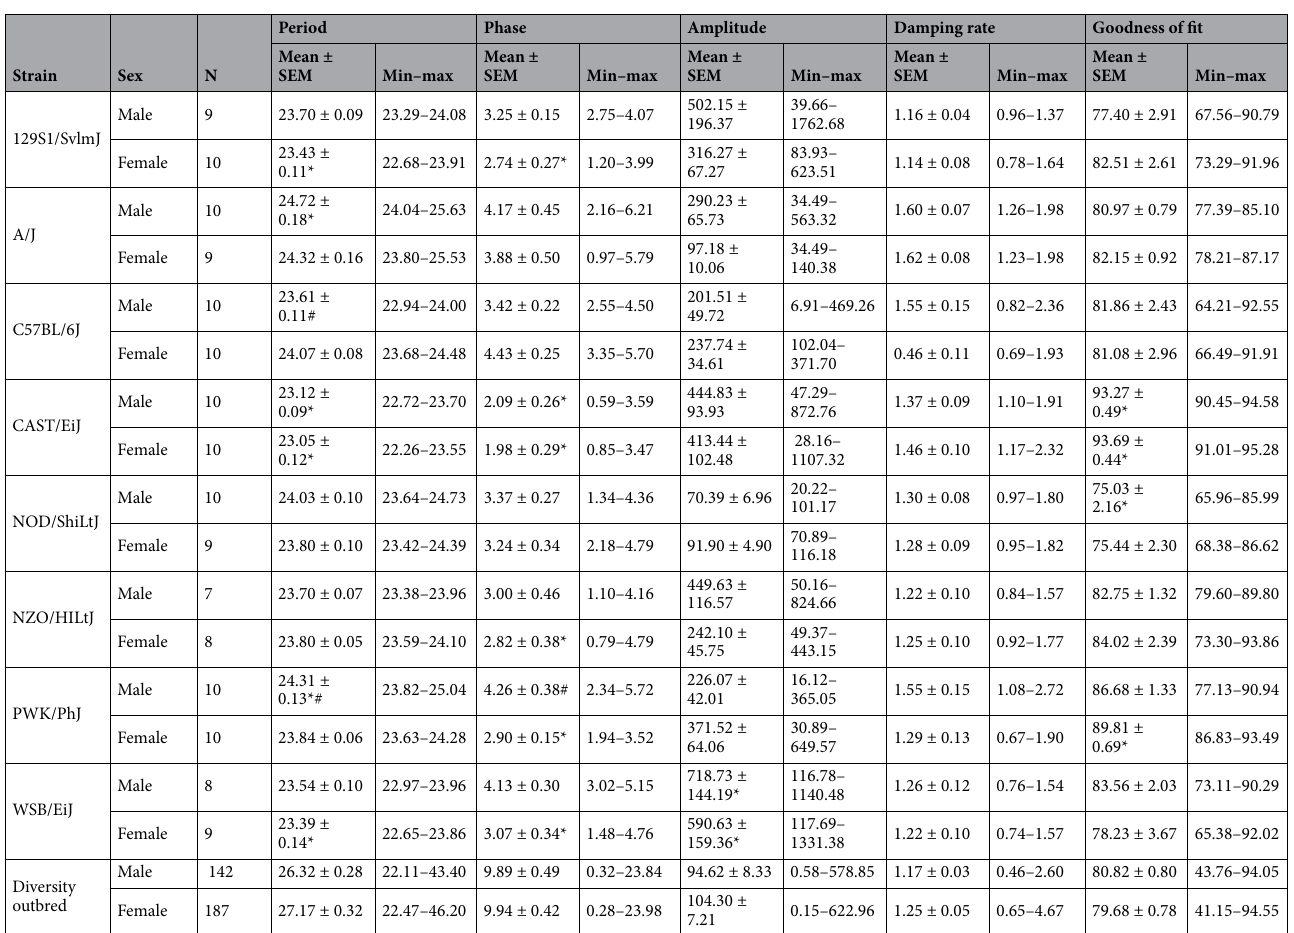
Table 2. Summary of circadian parameters of Bmal1-dLuc rhythms in cultured fibroblasts derived from DO mice and their founder strains. Asterisks indicate that circadian parameters are significantly (P < 0.05) different compared to C57BL/6J within the same sex. Hashtags indicate significant (P < 0.05) sex differences in period and phase of Bmal1-dLuc